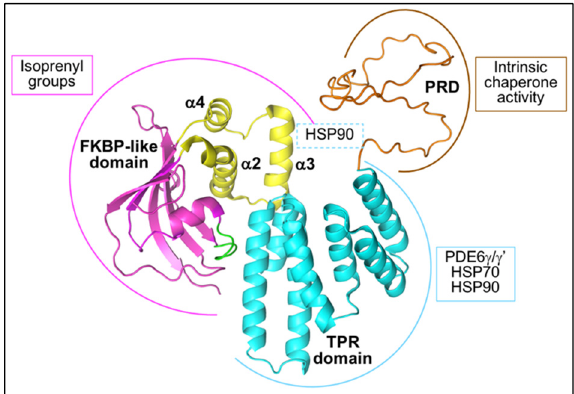
Figure 2. Model of AIPL1. The TPR domain (PDB 6PX0, cyan) and the FKBP-like domain (PDB 5U9A, magenta, yellow, and green) of AIPL1 were superimposed onto FKBP51 (1KT0). The PRD (brown) of AIPL1 was modelled using the I-TASSER server [74,75]. Helices 2, 3, and 4 of the unique insert region of the AIPL1 FKBP51-like domain (yellow) and the loop between β 4 and α 1 that adopts a ‘looped-out’ conformation in AIPL1 (green) are shown. The PRD is required for the intrinsic chap- erone activity of AIPL1. The TPR domain mediates the interaction with Hsp90/Hsp70 and the PDE6 inhibitory subunits, whilst Hsp90 may also make contact with the α 3 helix in the unique insert re- gion. The FKBP-like domain constitutes a ligand-binding site for isoprenyl groups. Figure courtesy of C. Prodromou, Genome Damage and Stability Centre, University of Sussex.